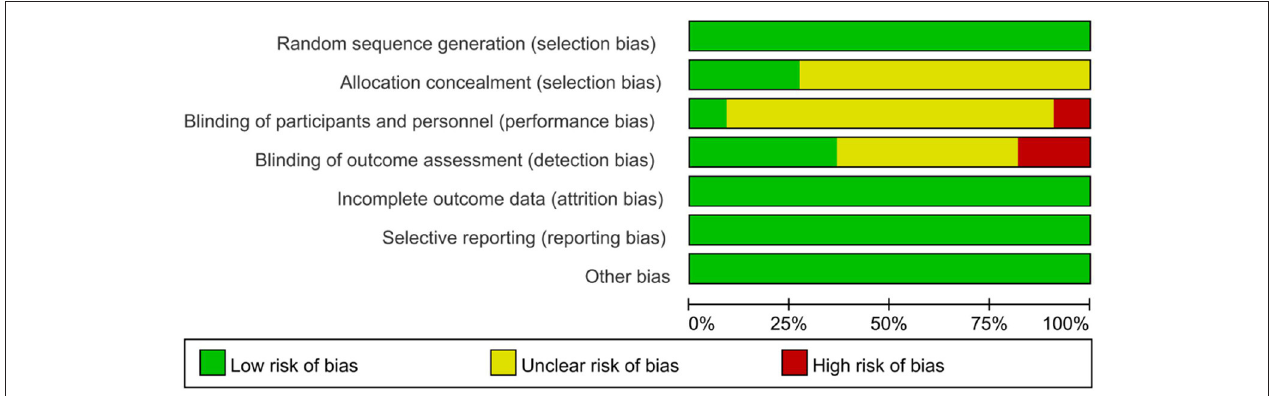
FIGURE 4 | Risk of bias assessment per domain across studies with domains of bias on the Y-axis and % of studies having a high, unclear, or low risk of bias in each domain on the X-axis. The total score is the final author judgment of the total risk of bias.